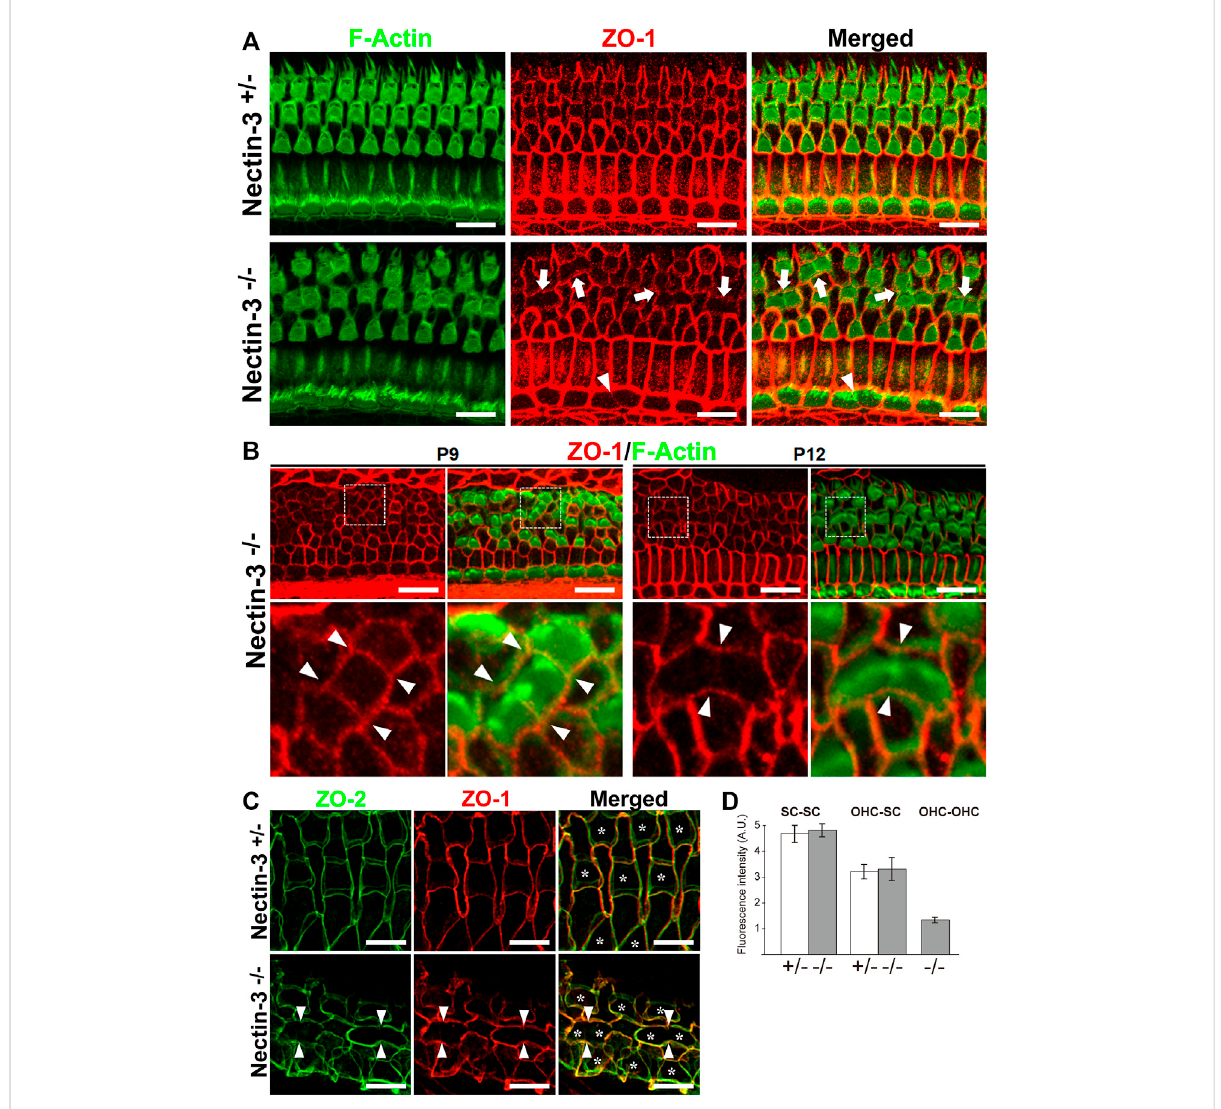
FIGURE 6 Localization of ZO proteins in the auditory epithelium in nectin-3 KO mice (A) Immuno fl uorescence images of the organ of Corti in the middle turn in nectin-3 +/ – and nectin-3 − / − mice on P12 using an anti-ZO-1 antibody (red) and phalloidin (green). White arrows indicate the homotypic interfacesbetweenattachedouterhaircells,andwhitearrowheadsindicatethehomotypicinterfacebetweenattachedinnerhaircells.Scalebarsare 10 μ m. (B) Immuno fl uorescence images of the organ of Corti in the middle turn in nectin-3 +/ – and nectin-3 − / − mice on P9 (left) and P12 (right). (Upper) Double immunostaining for ZO-1 (red) and F-actin (green). (lower) Close-up views of the white boxed region of the upper images. White arrowheadsindicatethehomotypicinterfacesbetweenattachedouterhaircells.Scalebarsare10 μ m. (C) Immuno fl uorescenceimagesoftheorgan of Corti in the middle turn in nectin-3 +/ – and nectin-3 − / − mice on P21. Double immunostaining for ZO-2 (green) and ZO-1 (red). White arrowheads indicate the homotypic interfaces between attached outer hair cells and asterisks indicate the outer hair cells. Scale bars are 3 μ m. (D) The fl uorescence intensities of ZO-1 atthe various junctionsin the organ of Corti in nectin-3 +/ – and nectin-3 − / − mice on P12 were quanti fi ed. SC-SC, the junctions between supporting cells, OHC-SC, the junctions between outer hair and supporting cells; OHC-OHC, the junctions between outer hair cells. Error bars indicate SD. Note that the junctions between outer hair cells are only detected in nectin-3 − / −